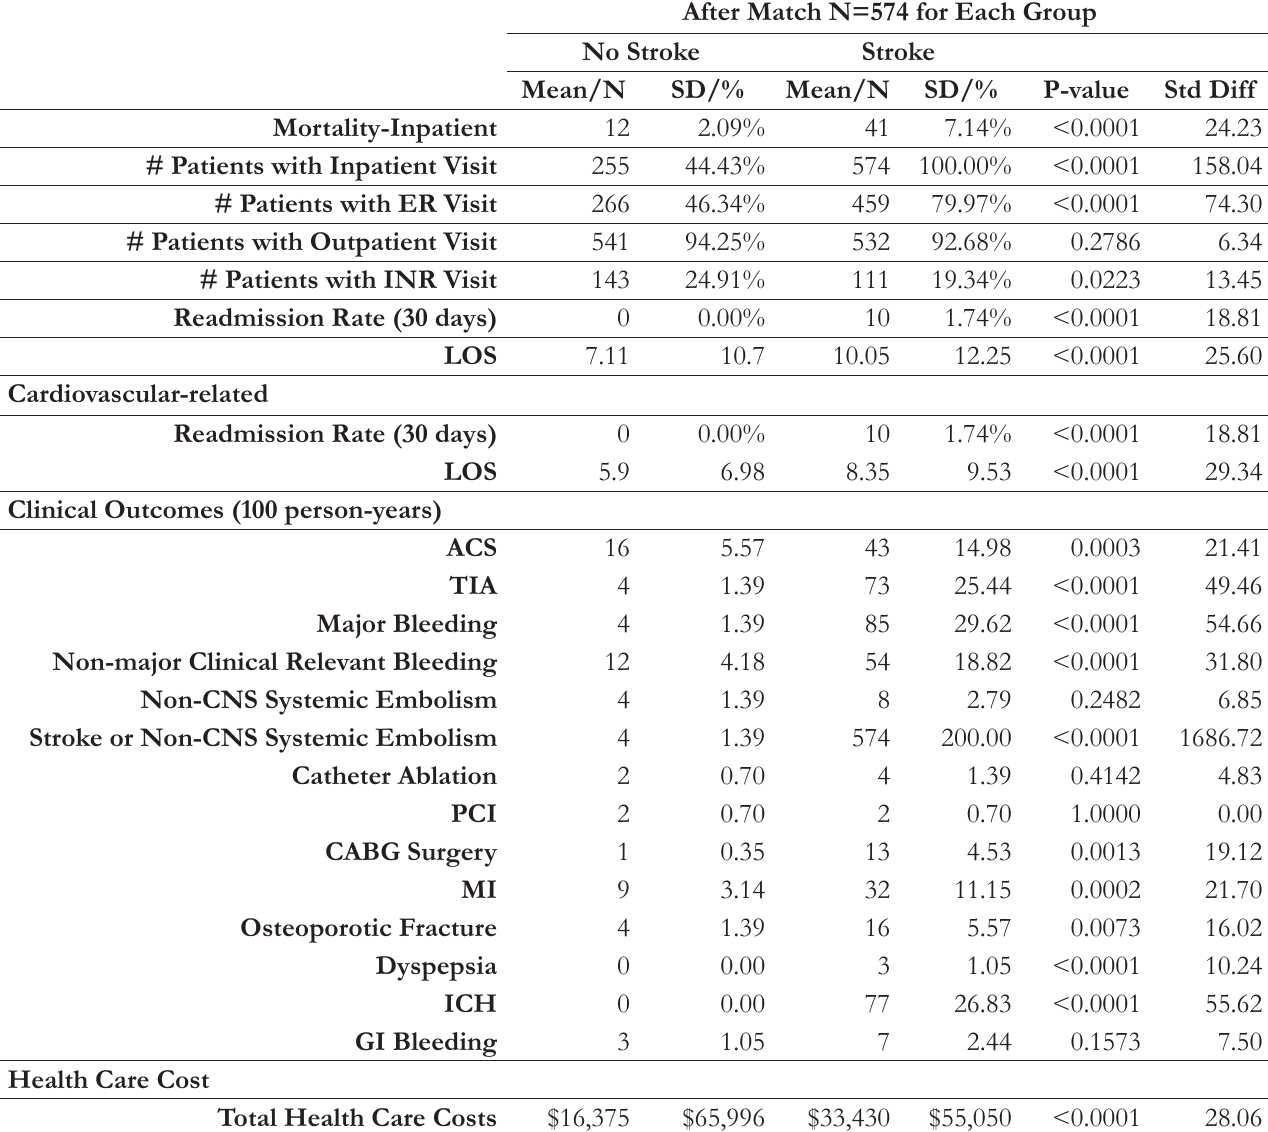
Table 3. Risk-adjusted Outcomes for NVAF Patients who did or did not Experience Stroke After Match N=574 for Each Group No Stroke